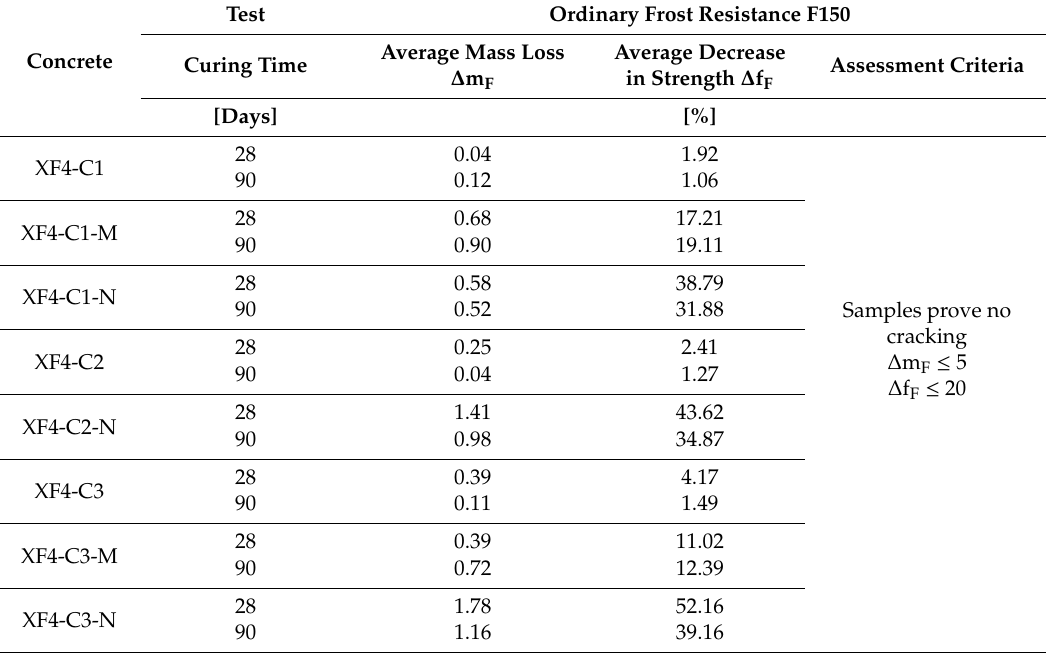
Table 10. Tests results of F150 frost resistance of concretes